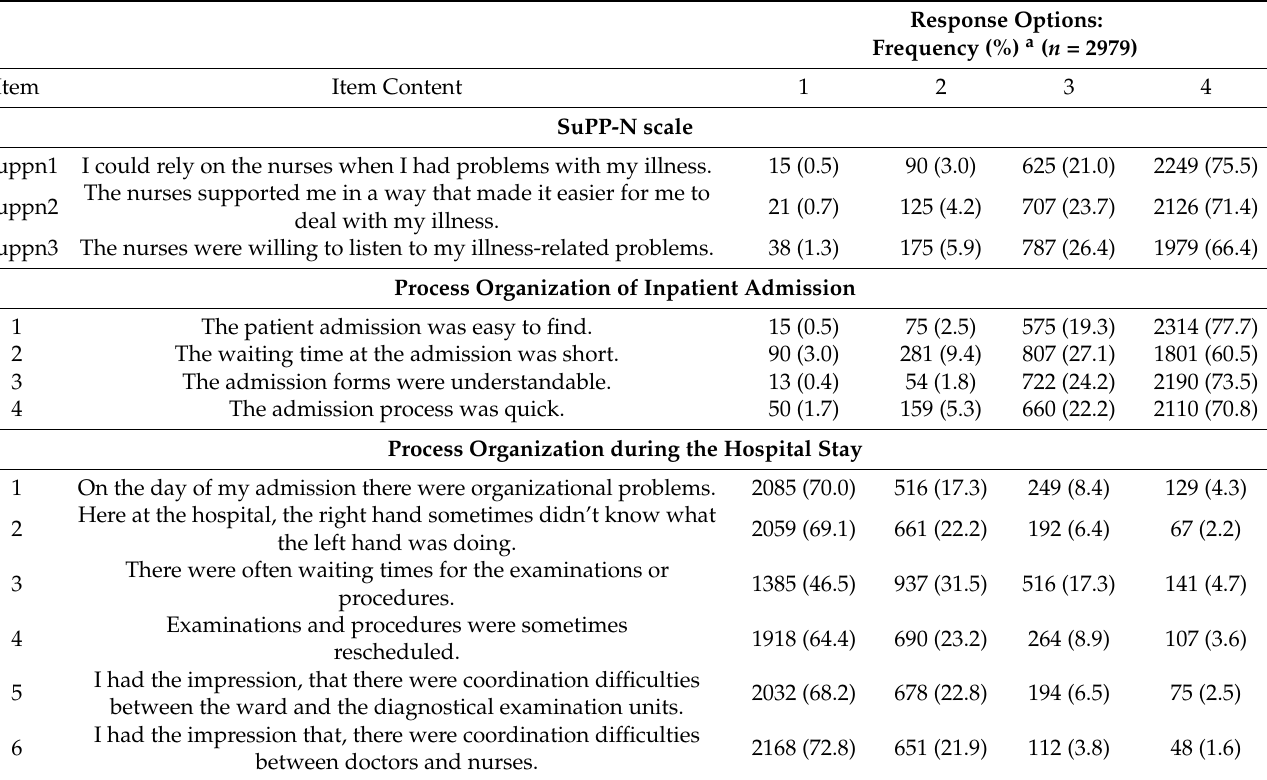
Table 1. Items of the scales measuring social support provided by nurses (SuPP-N) and measuring process organization.